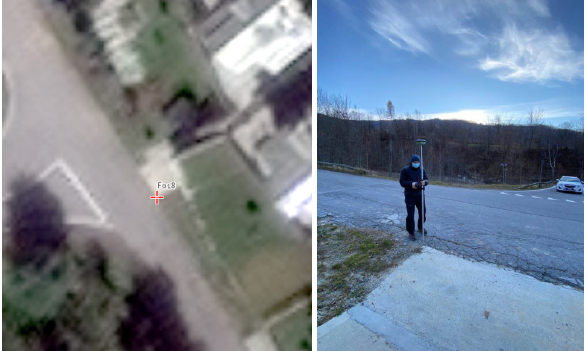
Figure 4 . Distribution of surveyed points (left) materialized and measured (right) in the area of Limone Piemonte village. Figure 5. Example of GCP used for satellite image geometric correction. Visual identification on the satellite image (left, red cross) and RTK GNSS measurement in the field (right). The residuals (in terms of RMSe, Root Mean Square error) on 5 GCPs, using an RPC model with a 1 st order correction, are (as expected) lower of the mean GSD, specifically: RMSeX = 0.43